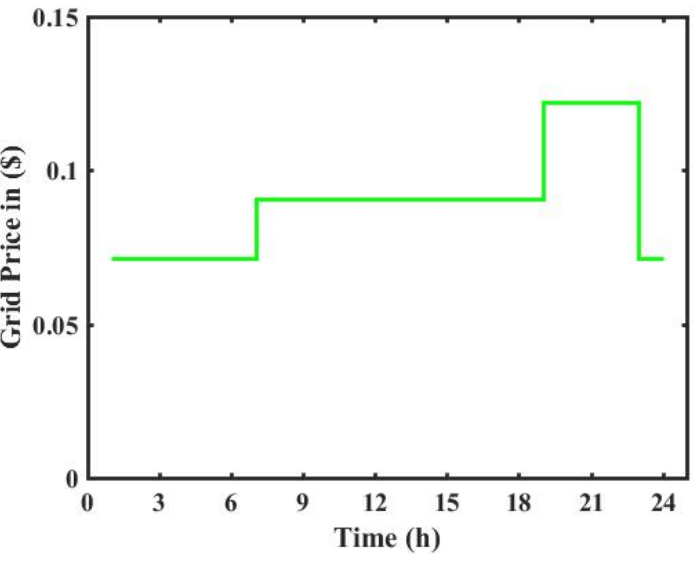
Figure 3. Grid price variation.